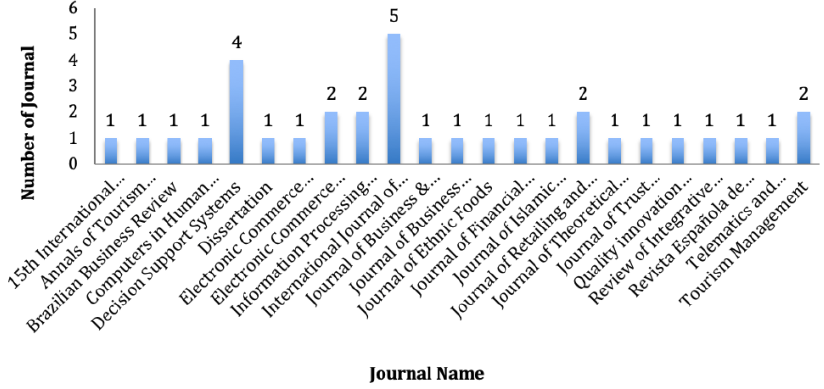
Figure 2: Distribution of studies based on journal